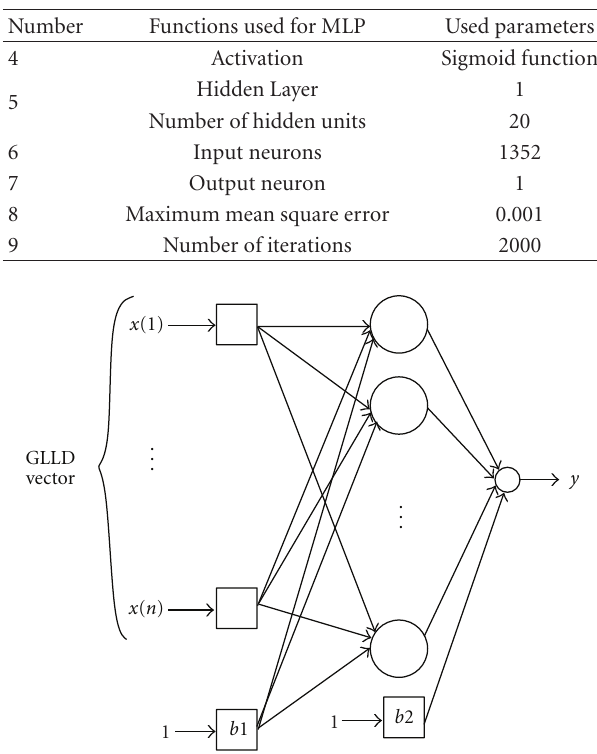
Table 3: Details of MLP network parameter.